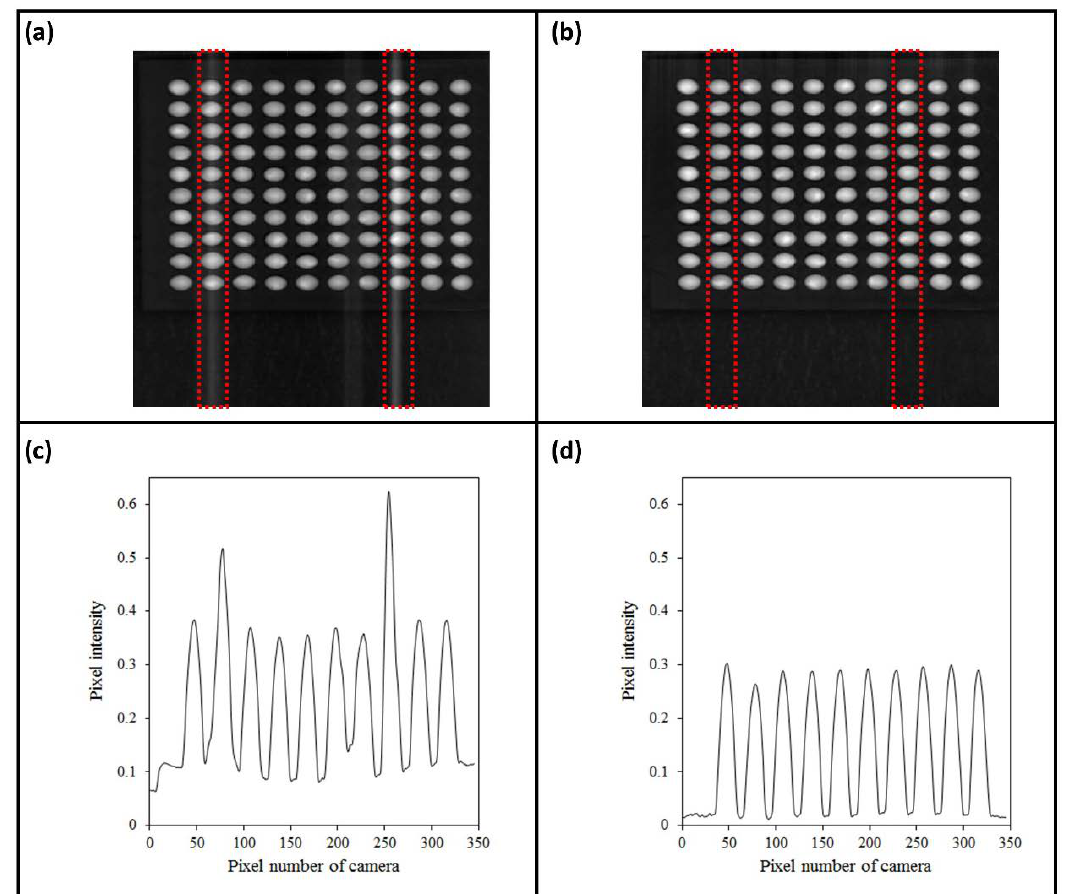
Figure 2. Hyperspectral band images of soybean seeds: ( a ) before and ( b ) after baseline correction and ( c , d ) showing average of corresponding pixel intensity.